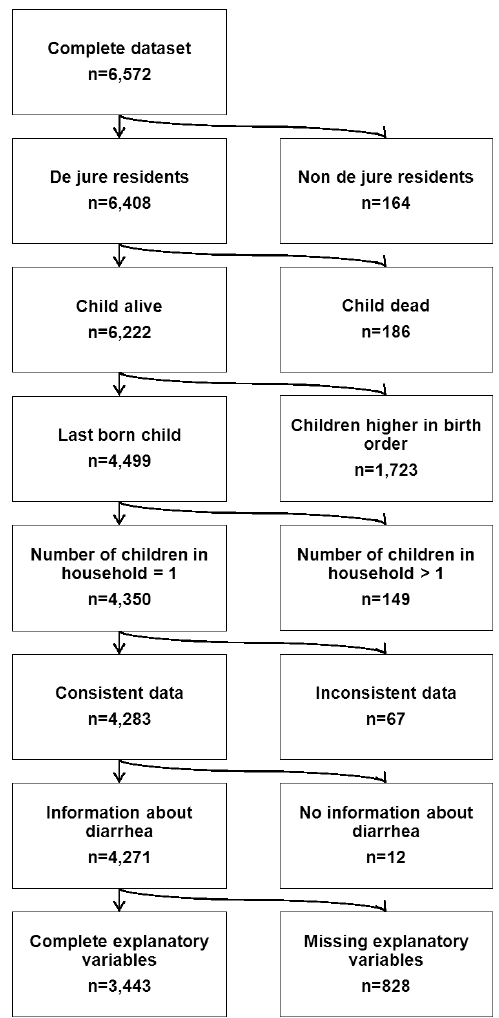
Figure 1. Flow chart of study population selection